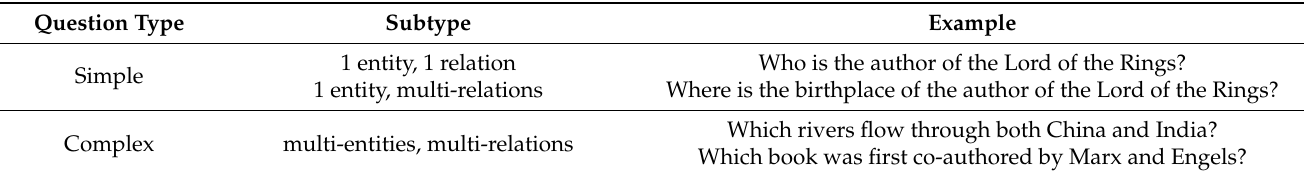
Table 1. Example questions for different